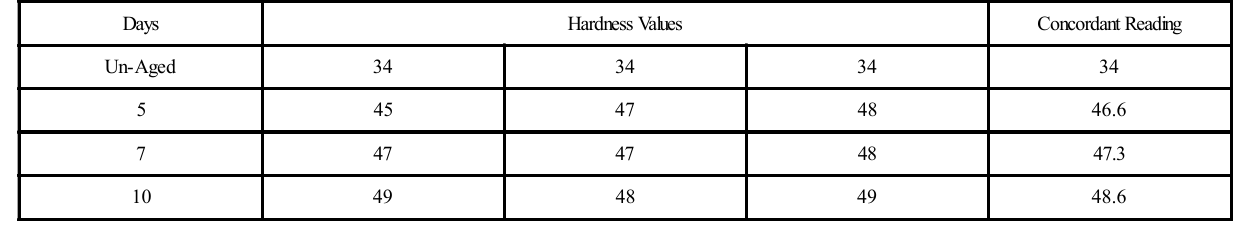
TABLE 5. SHORE HARDNESS OF AGED SAMPLES.